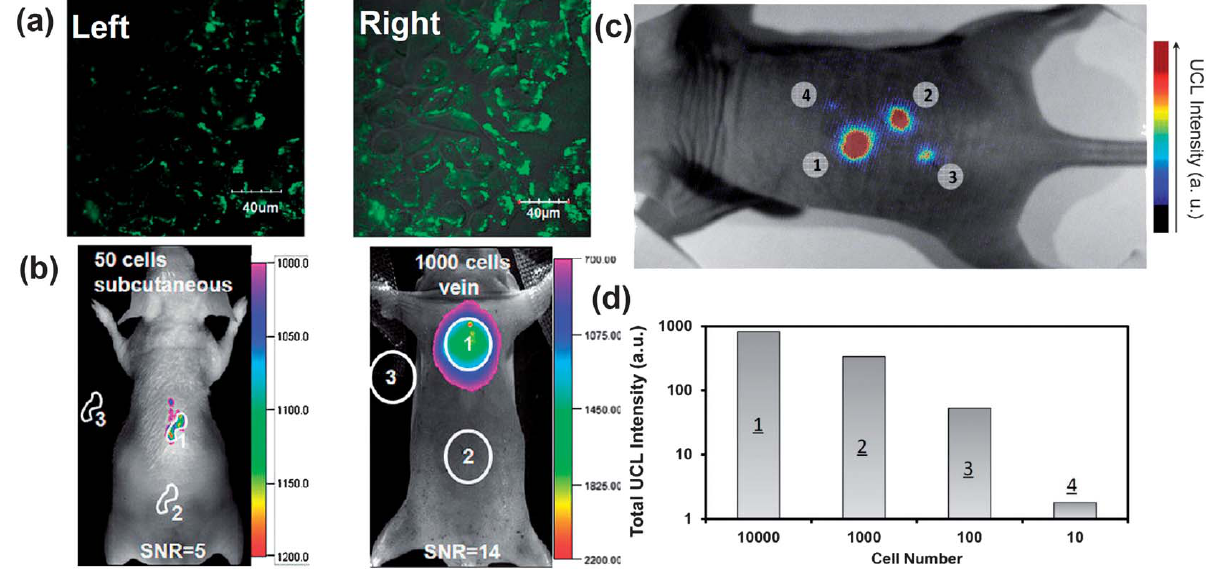
Figure 5. UCNPs for cellular labeling and in vivo tracking analysis. ( a ) Confocal UCNP imaging ( left ) and its overlay with a bright field image ( right ) of cells stained with 200 μ g mL − 1 NaLuF UCNPs for 3 h at 37 °C. ( b ) In vivo UCNPs imaging of athymic nude 4 mice after subcutaneous injection of 50 human nasopharyngeal epidermal carcinoma KB cells ( left ) and tail-vein injection of 1000 KB cells ( right ). The KB cells were pre-incubated with 200 μ g mL − 1 NaLuF4 UCNPs for 3 h at 37 °C before injection. ( c and d ) In vivo detection of UCNP-labeled mMSCs (an exogenous contast agent to track mouse Mesenchymal Stem Cells). ( c ) An upconversion luminescence image of a mouse subcutaneously injected with various numbers of mouse mesenchymal stem cells (1 × 10 5 ) labeled with UCNPs. ( d ) Quantification of UCNPs luminescence signals in ( c ). Adapted with permission from references [87,89], respectively. UCL, upconversion luminescence. Copyright: American Chemical Society, 2011; and Elsevier,